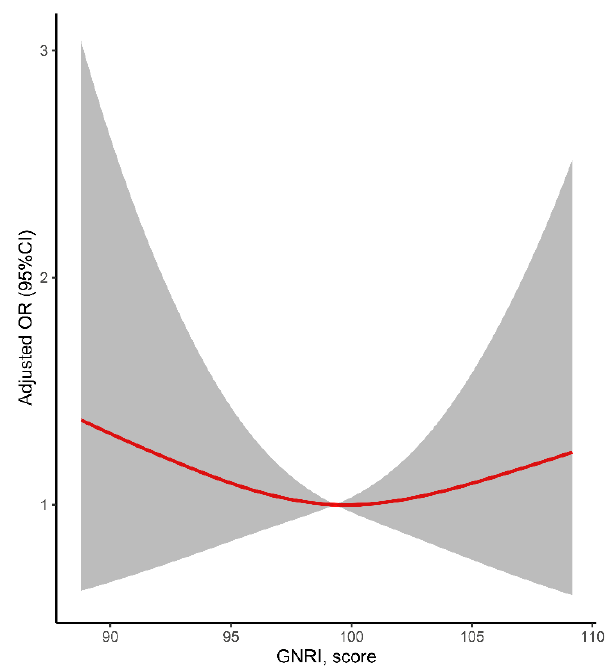
Figure 2. Relationship of GNRI and post-stroke depression in patients after ischemic stroke. Odds ratios and 95% confidence intervals derived from restricted cubic spline regression ( p for nonlinearity = 0.354), with knots placed at the 5th, 50th, and 95th percentiles of the distribution of GNRI scores. The reference point was set at a GNRI value of 100. Odds ratios were adjusted for the covariates included in Model 3 in Table 2.